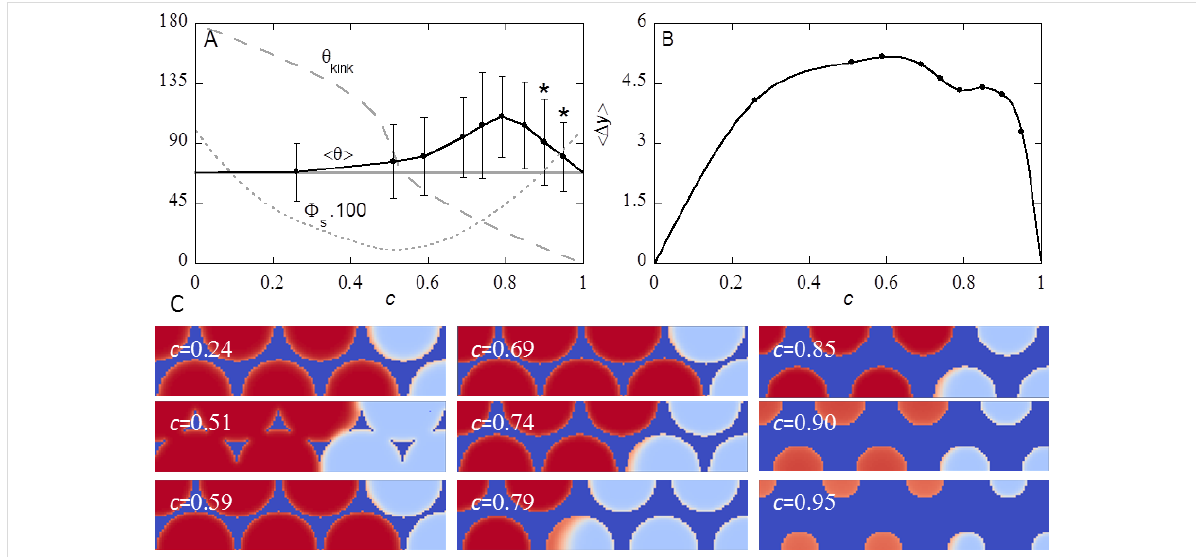
Figure 13: A) Advancing contact angle and the corresponding standard deviation as measure of variation in the x -direction as function of the cut- off fraction c . The horizontal grey line is the contact angle θ Y on a smooth surface, the grey dashed line is the angle of the kink θ kink at different values of c and the grey dotted line is Φ S ∙ 100. Stars indicate that the cavities under the water front are filled with vapour (Cassie–Baxter wetting state). B) Corresponding average variation in y -position at z = h + 3 as function of the cut-off fraction c . The hexagonally ordered inverse opal has cavity diameter d = 39, spacing between the cavities s = d − 1 =38, and χ S = − 0.3. C) The distribution of solid S at the top layer of the substrate, that is φ S ( x , y , h ). The dark blue colour implies density of the solid is unity. The red colour indicates that the opening of the cavity is filled by the solvent. The light blue colour means that the cavity opening is filled with vapour. Orange colour implies that the solvent density is in between the liquid and the vapour. The value of c is